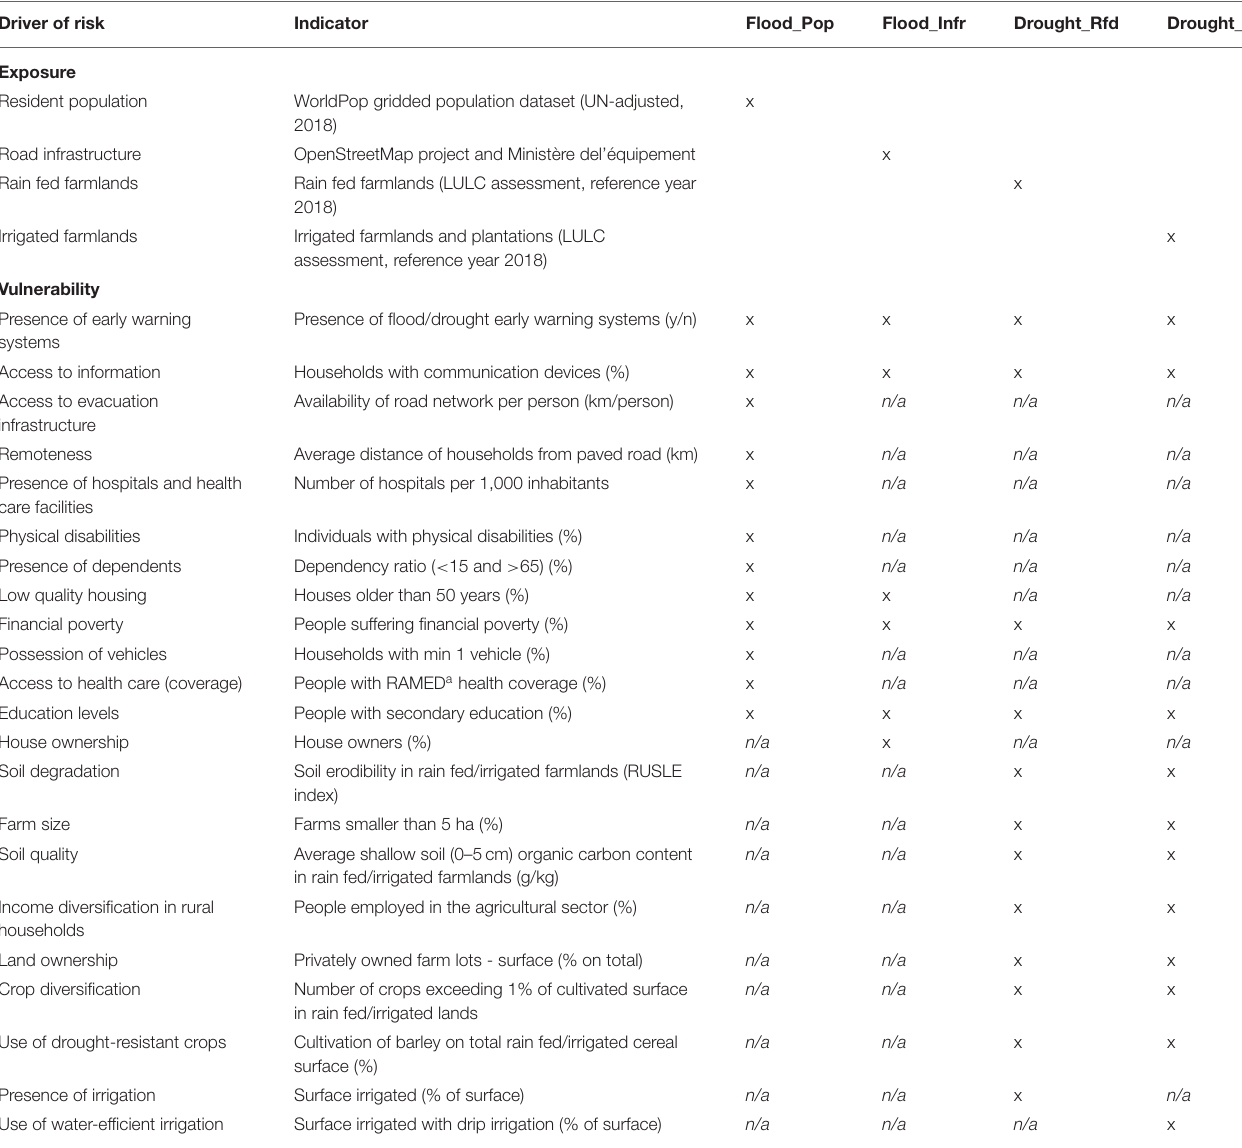
TABLE 2 | Drivers and indicators of risk for the four single-risks considered in the study. Driver of